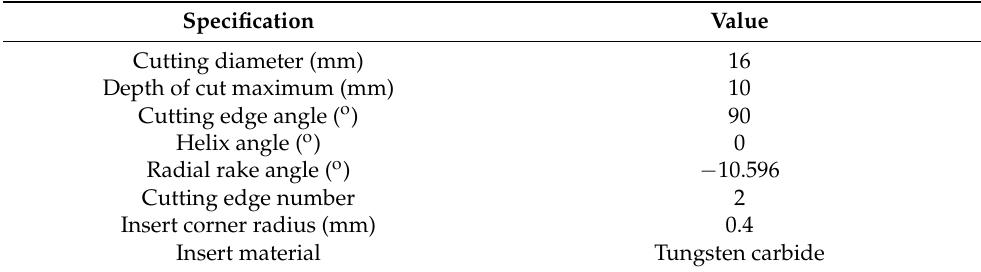
Table 5. Cutting tool specifications.